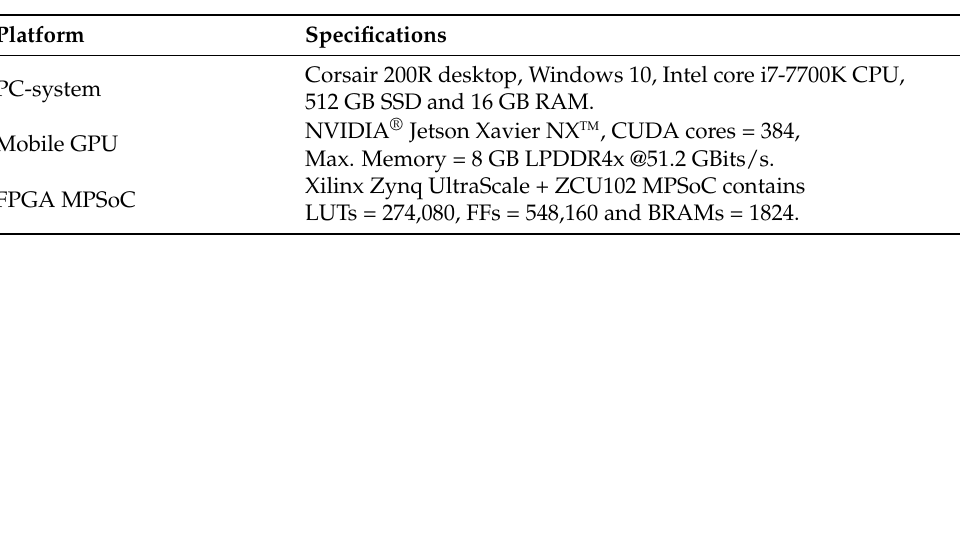
Table 4. PC-system, mobile GPU and FPGA